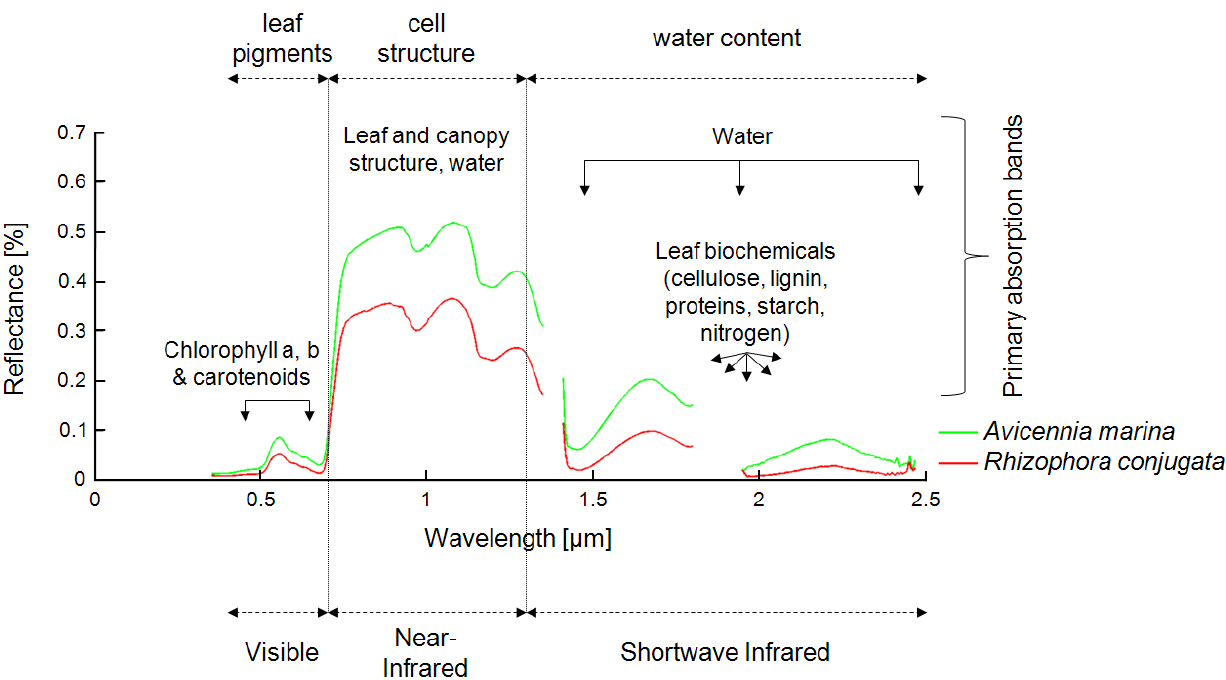
Figure 3. Spectral characteristics and their influencing parameters of the mangrove species Avicennia marina and Rhizophora conjugate as measured with an field spectrometer in Ca Mau Province, Vietnam, January 2010. Stacks of at least eight layers of mangrove leaves were measured, filling the instantaneous field of view, IFOV, of the spectrometer to grant optimal leaf area index (LAI) conditions without background